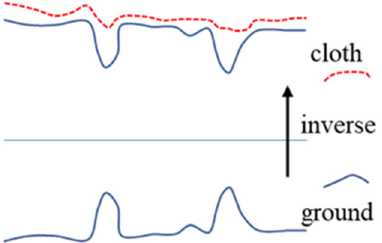
Figure 5. The idea of the cloth simulation method.